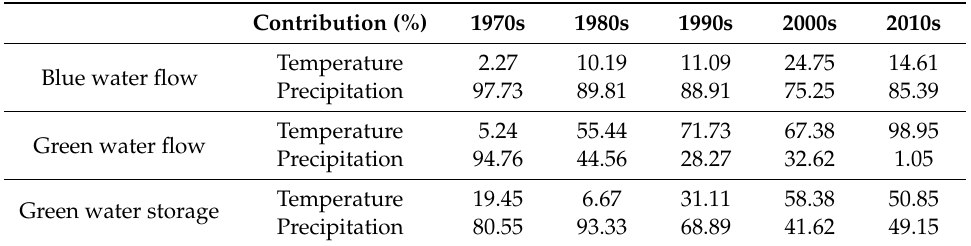
Table 5. The contribution rates (%) of temperature and precipitation for hydrological components in Luanhe River